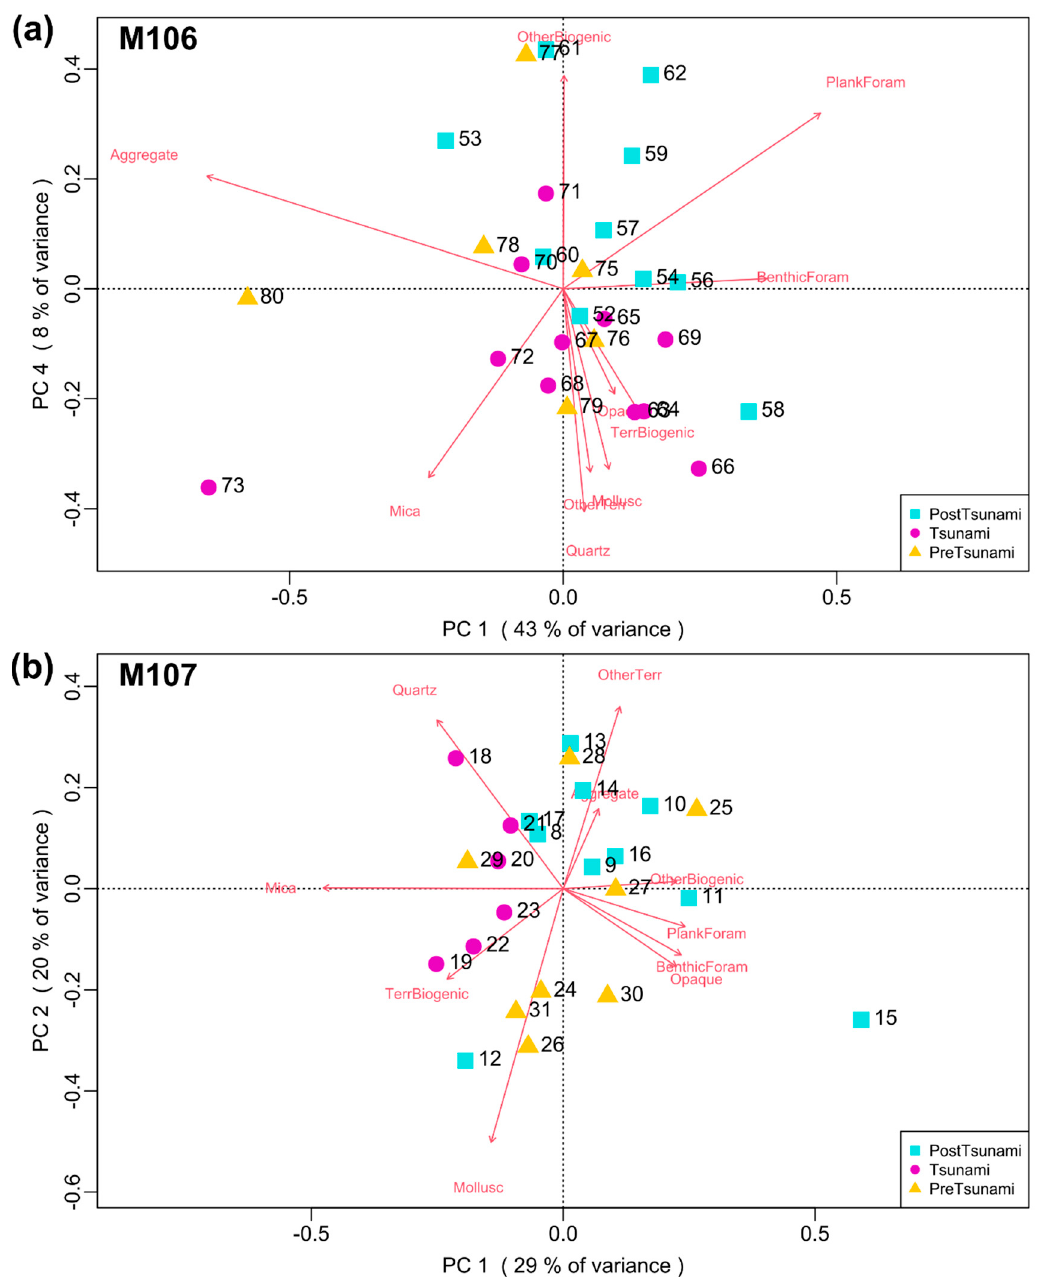
Figure 10. SC PCA-biplot (scaling 1) of core M106 ( a ) and M107 ( b ) showing the samples colored after their respective chronological group and the SC variables (red arrows).